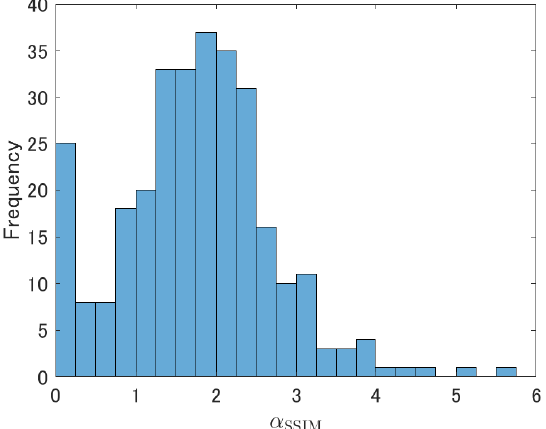
Figure 6. Histogram of the 𝛼 values that maximize the SSIM for each output